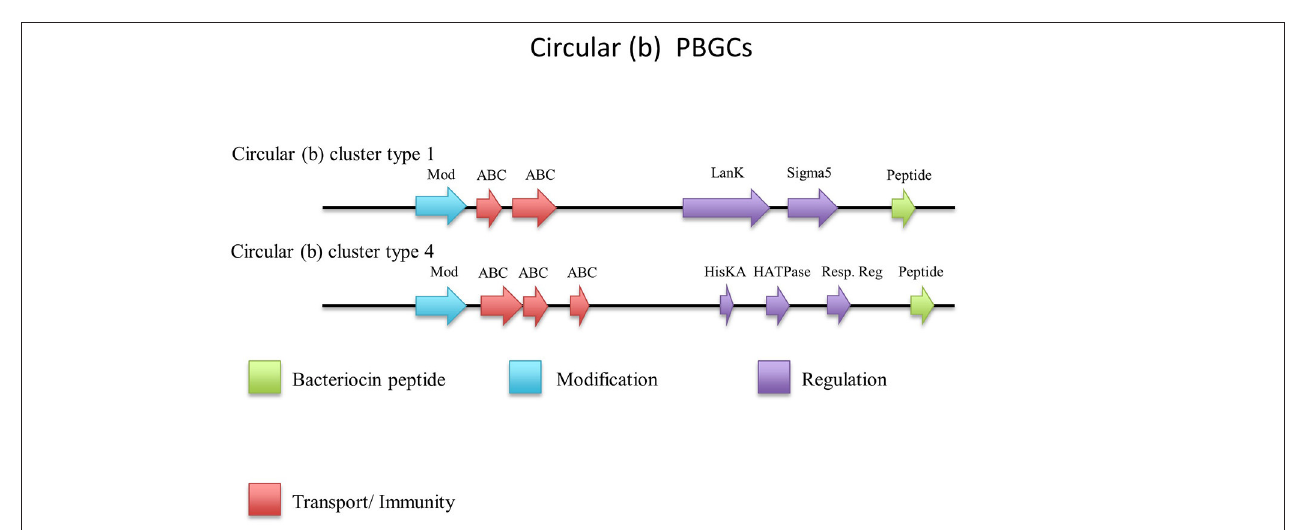
FIGURE 11 | Circular (b) cluster types predicted by